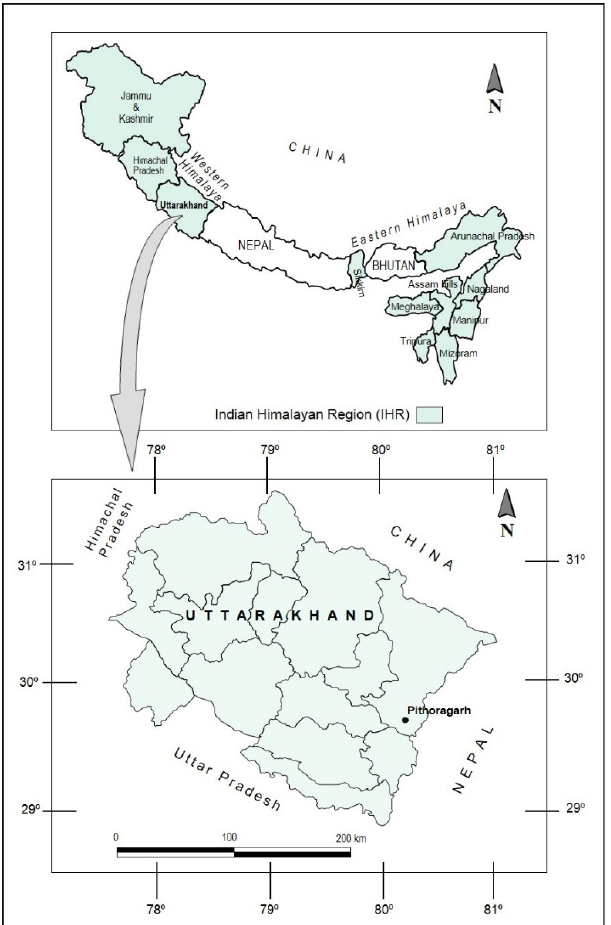
Figure 1. Location of the study area in the Indian Himalayan Region